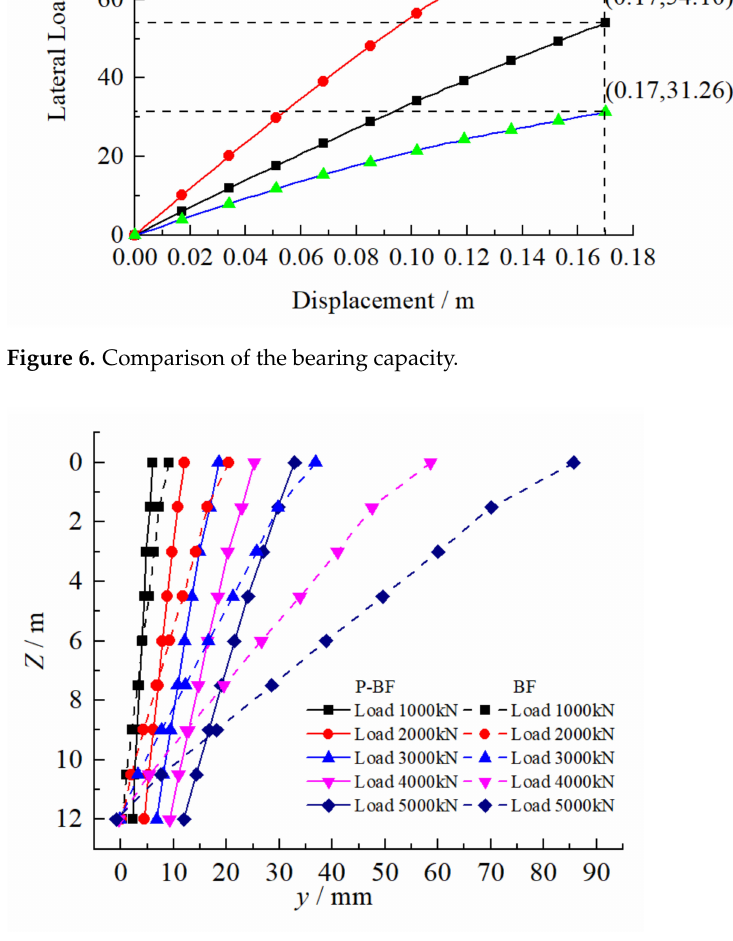
Figure 7. Comparison of lateral displacement between P–BF and